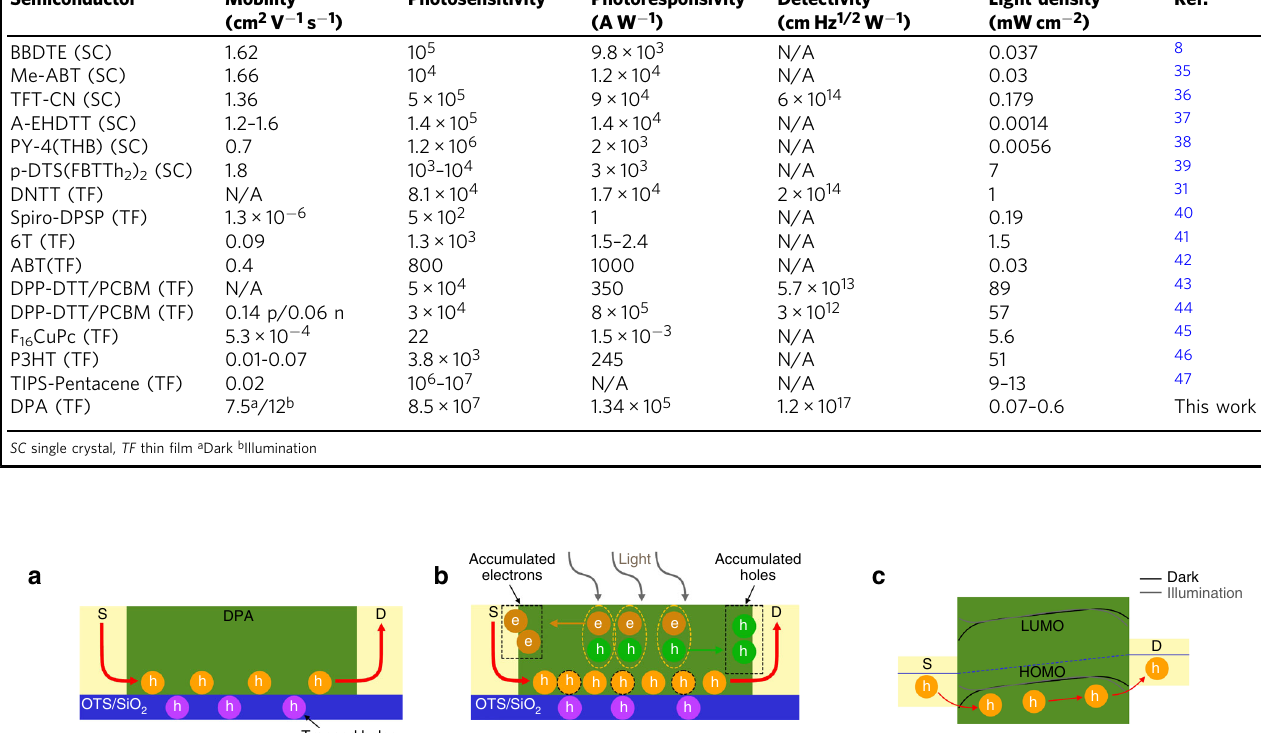
Table 1 Comparison of current work with representative phototransistors based on organic semiconductors